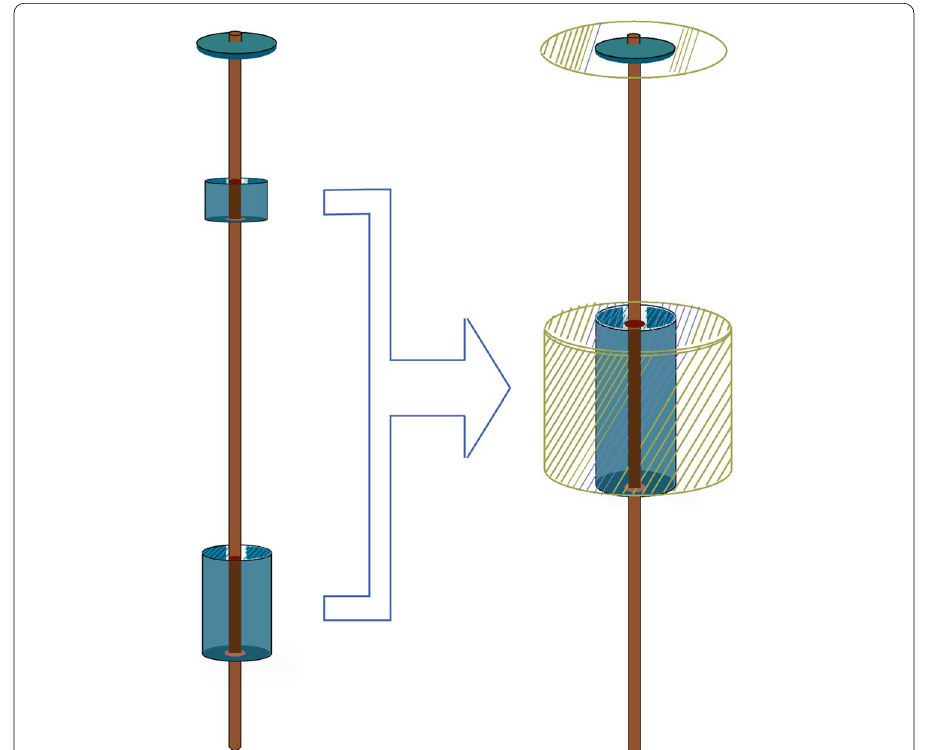
Fig. 3 Sketch showing the assumption of merging of the feed zones. The outer cylinder is the resulting volume of the